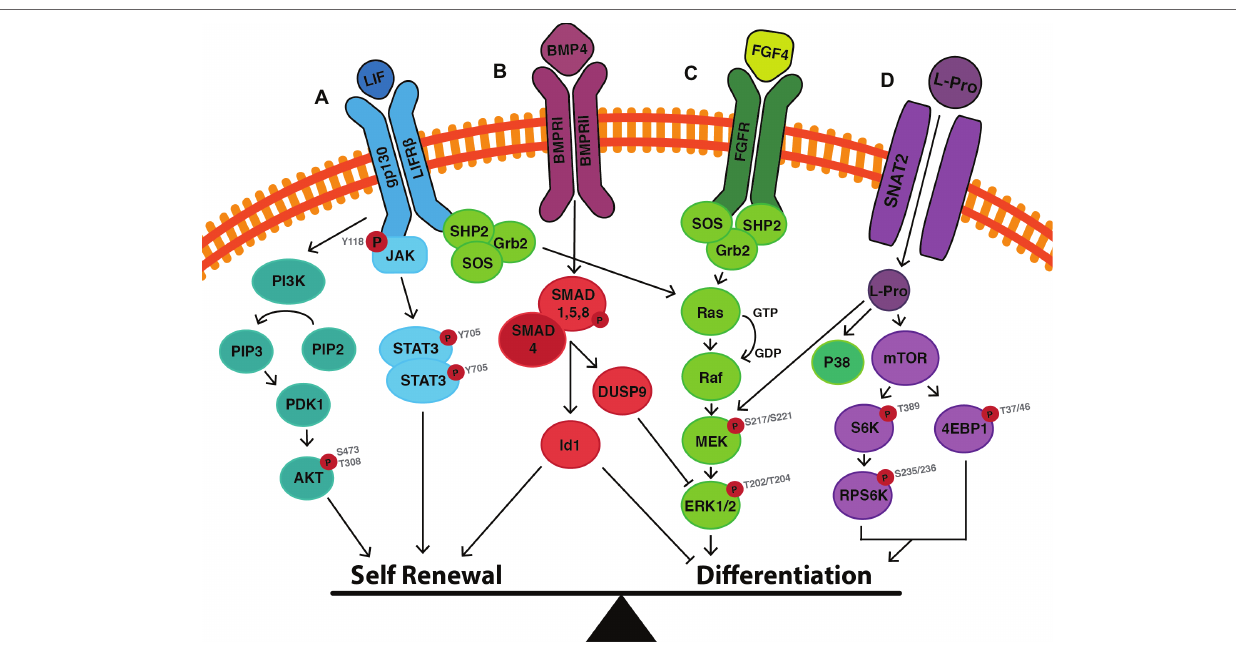
FIGURE 7 | Cell signalling events that mediate the switch between self-renewal and differentiation in mouse embryonic stem cells. (A) LIF binds to the LIF receptor (LIFR) resulting in heterodimerisation with glycoprotein-130 (gp130). Downstream JAK proteins become phosphorylated, and in this active state phosphorylate tyrosine residues on the receptor complex. STAT3 can then dock to the receptor, is then phosphorylated at Y705, and homodimerises before translocating to the nucleus where it induces the transcription of self-renewal genes. LIF also activates the PI3K pathway, in which PIP 2 is converted to PIP 3 resulting in the downstream phosphorylation of AKT at S473 and T308. This enhances self-renewal by upregulating the expression of Nanog, and by promoting cell cycle progression. (B) BMP4 binds to its cognate BMP receptor (BMPR) resulting in the phosphorylation of SMAD1/5/8. Once phosphorylated, SMAD1/5/8 forms heterodimers with SMAD4, which translocate to the nucleus resulting in transcription of inhibitor-of-differentiation ( Id ) genes. SMAD signaling also results in the upregulation of the phosphatase DUSP9 which acts as a negative regulator of ERK, thereby inhibiting differentiation. (C) LIF also activates the MAPK/ERK pathway to promote differentiation in the face of maintaining self-renewal. The balance can be tipped toward differentiation by the presence of Fibroblast Growth Factor (FGF4), which upregulates the activity of the MAPK/ERK pathways, as does (D) L-proline. L-proline enters the cell via the Sodium-coupled Neutral Amino Acid Transporter (SNAT)-2 where it activates mTOR to induce the differentiation of mESCs to early primitive ectoderm-like (EPL) cells. Figure adapted from data published in: (Ying et al., 2003b; Paling et al., 2004; Binétruy et al., 2007; Washington et al., 2010; Hirai et al., 2011; Romero-Lanman et al., 2012; Hamilton and Brickman,